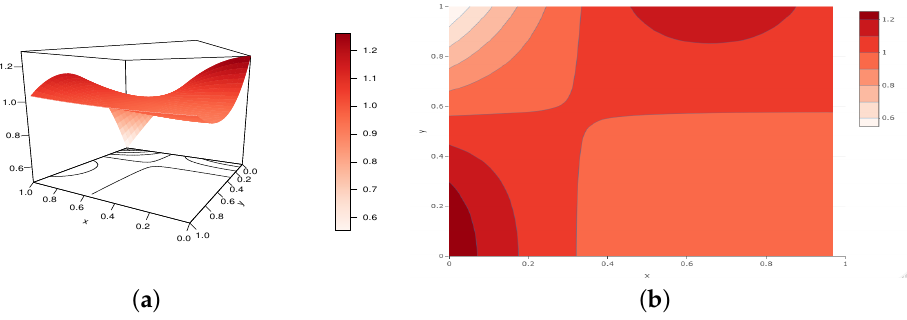
Figure 13. Illustrations of the ( a ) perspective plot and ( b ) contour plot of the TGCC copula density for the following configuration: a = 1/4 and b = c = 2, belonging to Configuration 1.